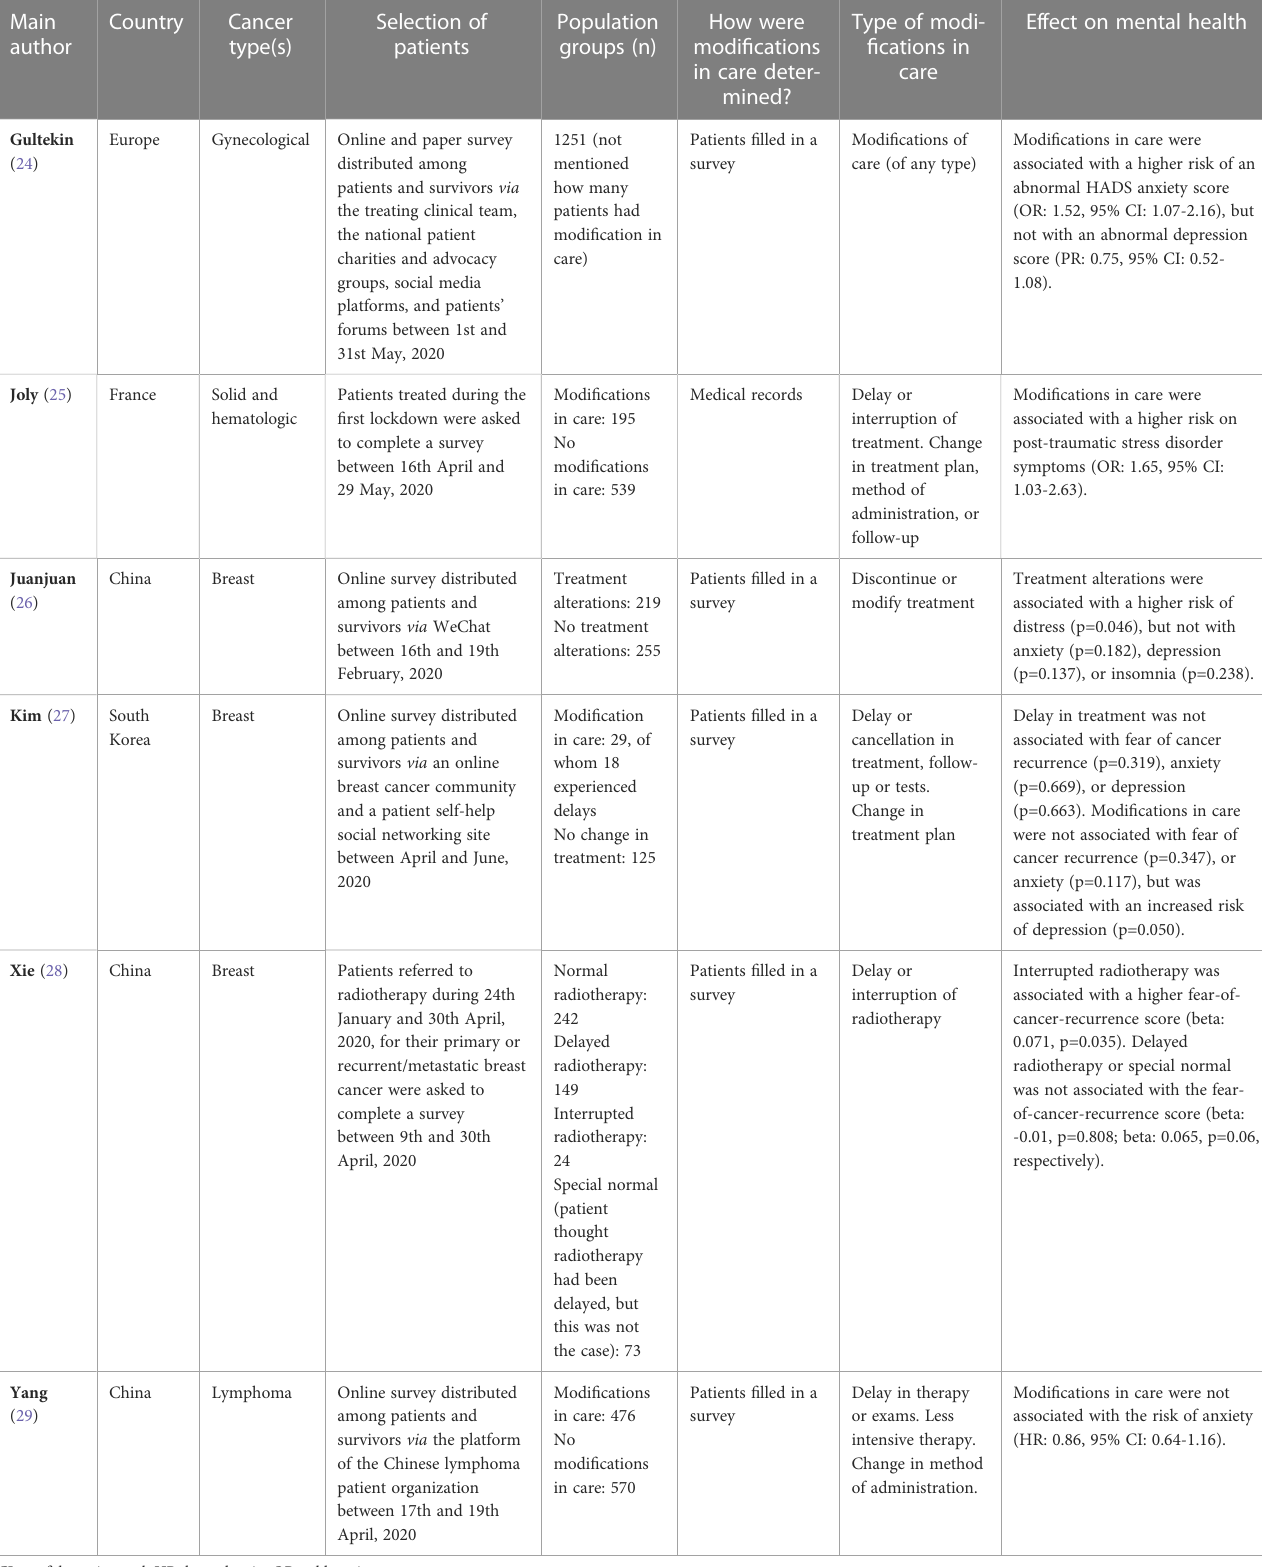
TABLE 4 Effect of the Covid-19 induced modi fi cations in care on mental